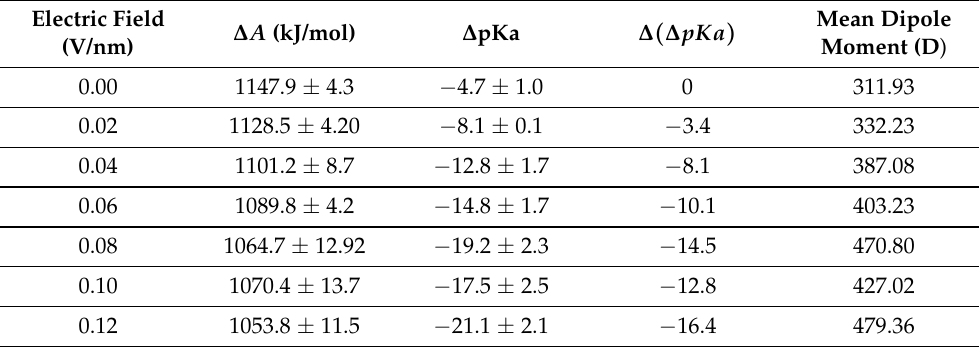
Table 3. Effect of a static electric field on the Helmholtz Free Energy change and on the pKa for Cysteine 35 in TRX.